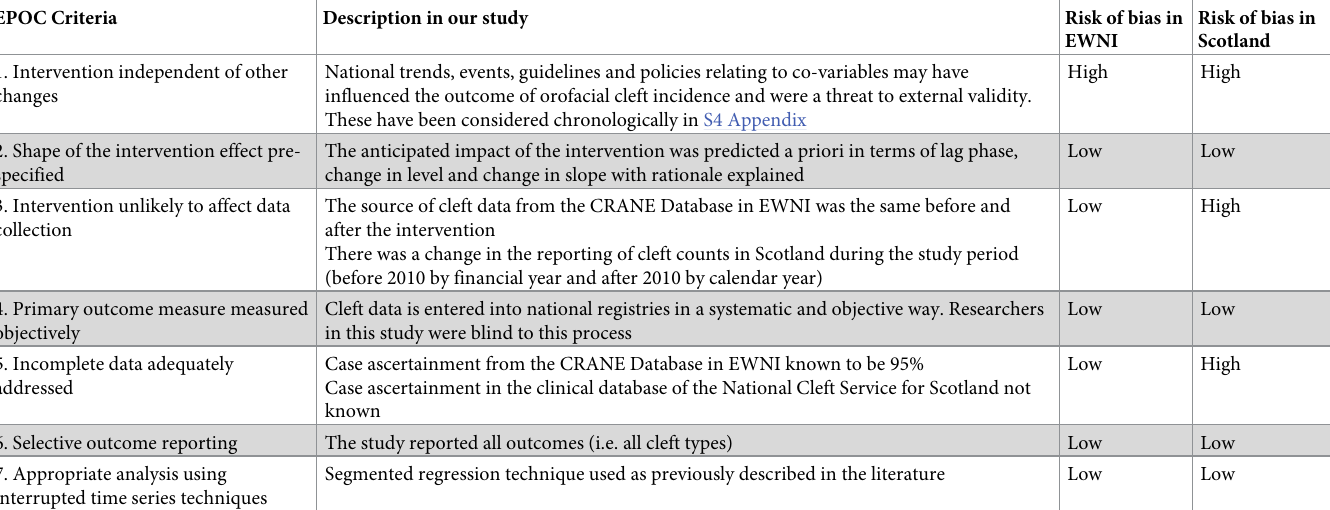
Table 2. Cochrane Effective Practice and Organisation of Care (EPOC) [42] criteria to assess the risk of bias in interrupted time series studies in the datasets for England, Wales and Northern Ireland (EWNI) and for Scotland. EPOC